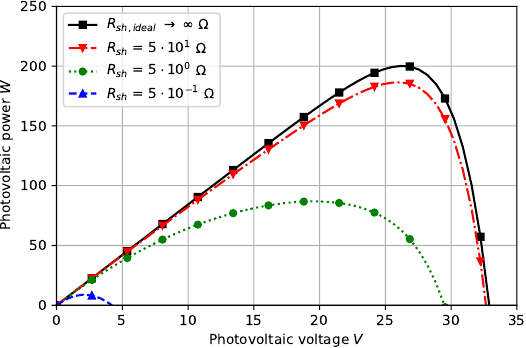
Figure 6. Behavior of the power as a function of the voltage for different values of R sh on the SDM, considering R s = 0 Ω